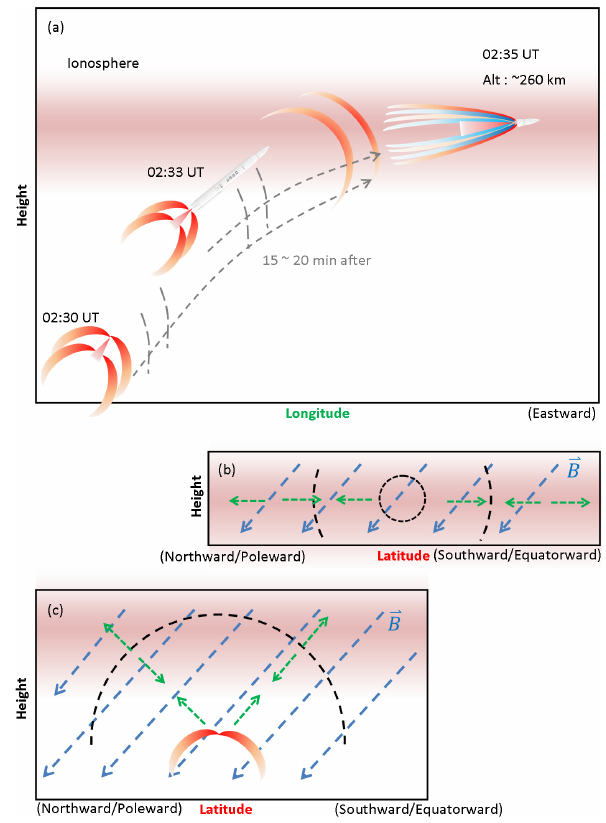
Figure 6. The illustrations demonstrate (a) the delayed bow waves generated by the exhaust plume released at earlier rocket locations at lower altitudes and propagated outward/upward from the source region toward higher altitudes (the altitudes and time tags are based on the 2009 NK event); (b) the conditions for the neutral density perturbation waves generated by released plume at the rocket’s cur- rent location where the outward propagation of neutral perturbation waves produce no north–south asymmetry in plasma perturbation waves; (c) the conditions for the neutral density perturbation waves coming from lower altitude which lead to prominent tendency to- ward equatorward/southward propagation of plasma perturbation waves. The blue dashed arrow lines indicate magnetic field lines, while the green dashed arrow lines indicate the disturbance